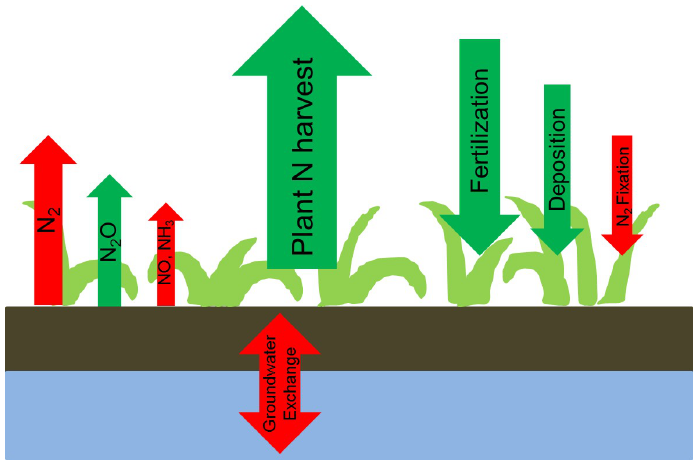
Figure 1. N fluxes of the investigated grassland. Green arrows correspond to measured quantities, red arrows represent unmeasured fluxes.